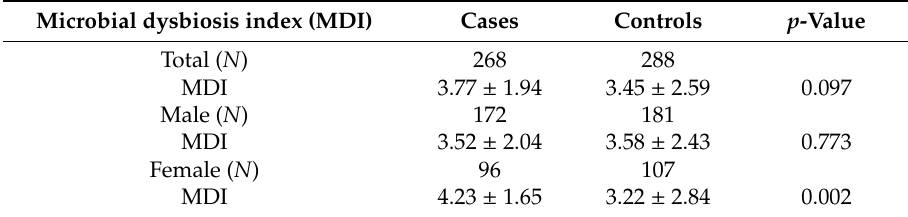
Table 3. Comparison of the Microbial dysbiosis index (MDI) between cases and controls.